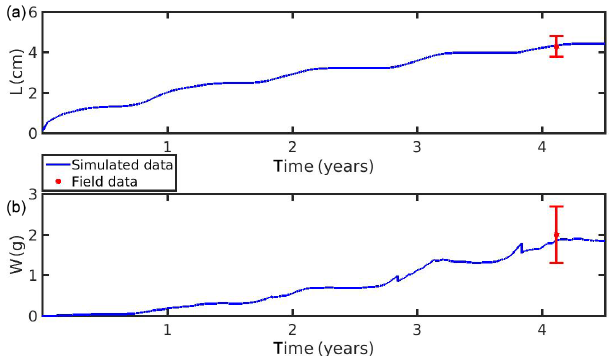
Figure 3. (a) Simulated mussel shell length ( L ) and (b) fresh tis- sue mass ( W ) against North Sea data (red star: mean ± SD), using chlorophyll a , X = [ CHL a ] , in the mussel